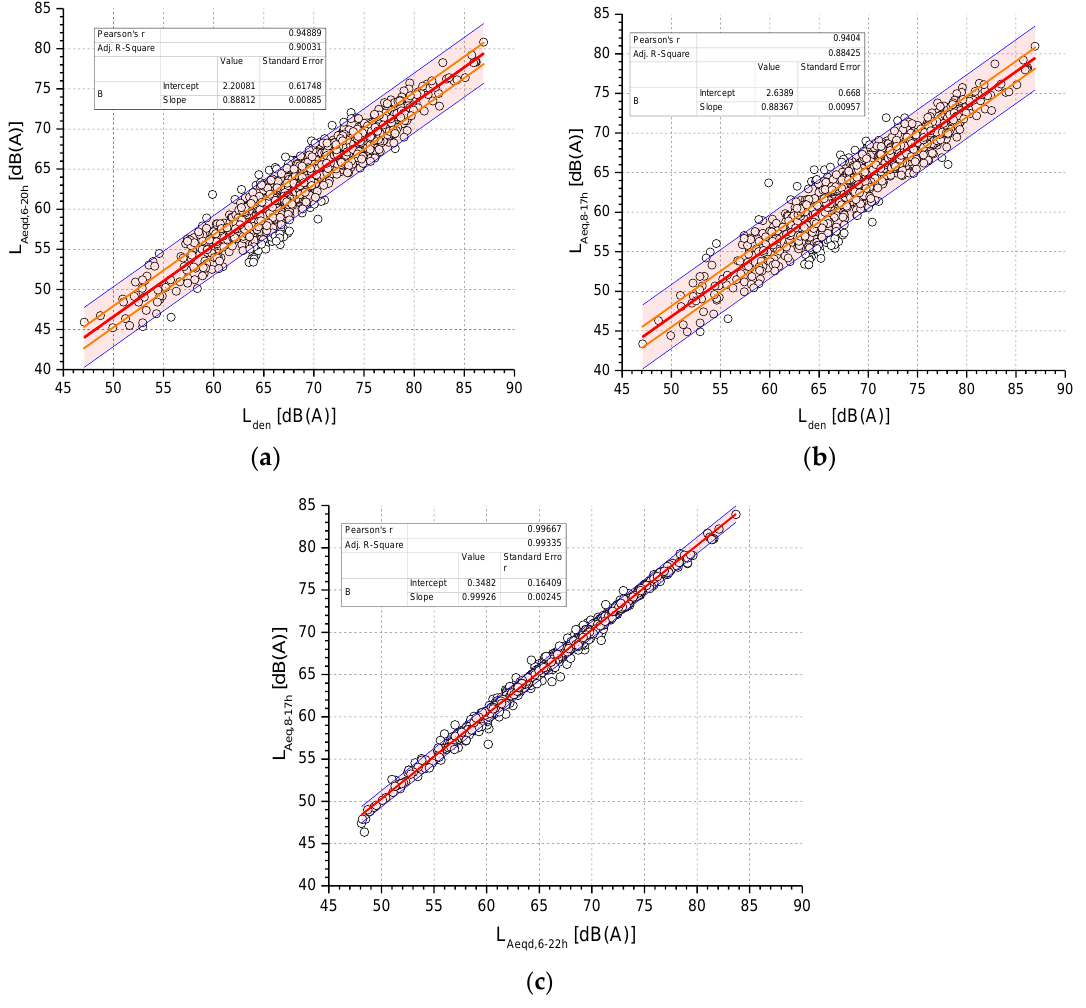
Figure 2. Linear regression between L den and L Aeqd, 6 – 20 h ( a ), L den and L Aeq, 8 – 17 h ( b ), L Aeqd, 6 – 22 h and L Aeq, 8 – 17 h ( c ).